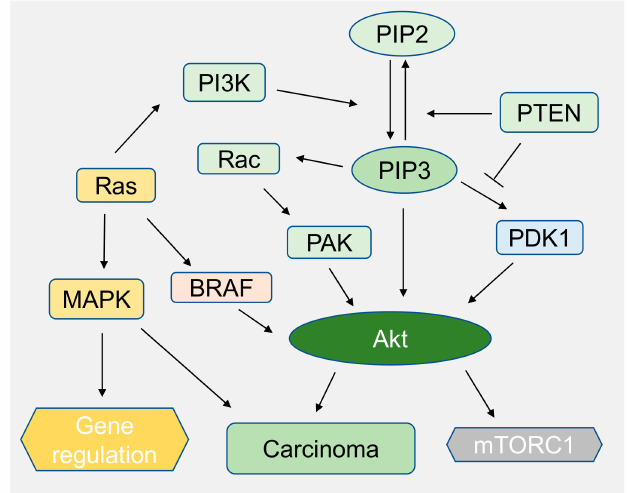
Figure 8. PIP 3 and MAP kinase pathways synergistically and independently regulates melanoma cancer or any other carcinoma. Ras regulates both PI3 and Akt kinase pathways. In addition, Ras independently regulates BRAF which is also implicated in Akt3 activity depicted in